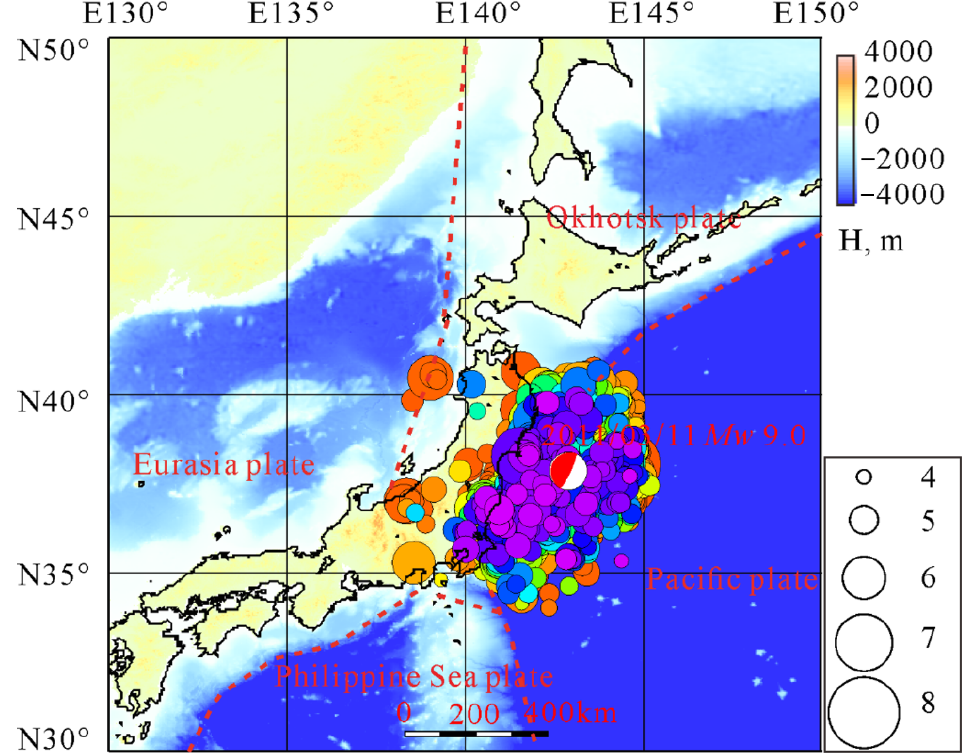
Figure 1. Seismotectonics of the study region. Aftershocks from the United States Geological Survey (USGS) catalog from 11 March 2011 to 10 April 2011 are shown by colored dots with radii proportional to the magnitude. The Mw 9.0 focal mechanism is based on Harvard Centroid Moment Tensor (CMT) results.